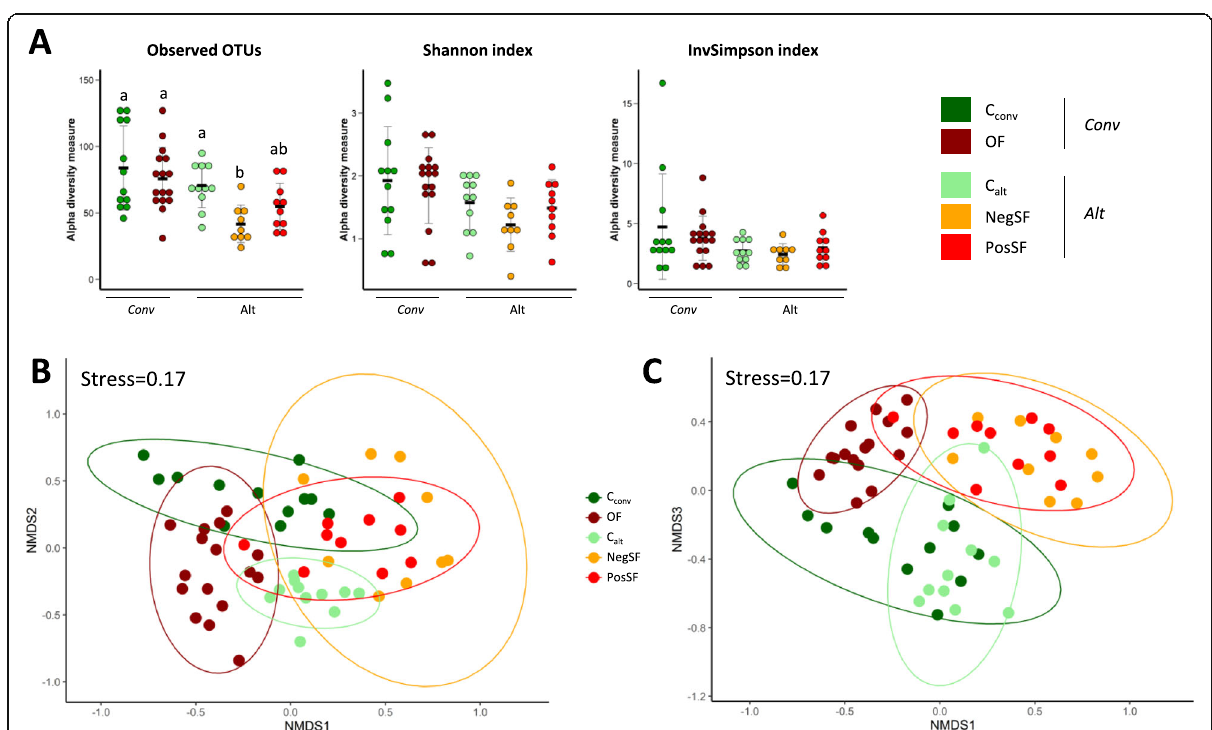
Fig. 3 Alpha and Beta diversity of the microbial community according to the experimental group. a Alpha diversity, means are presented by black horizontal lines and SD as grey error bars; b - c nMDS representation of the beta diversity (Bray Curtis, stress = 0.17) according to ( b ) axes 1 and 2 and ( c ) axes 1 and 3. Conv: Conventional breeding system, Alt: Alternative breeding system. C conv : Control group before overfeeding, OF: Overfed group, C alt : Control group before Ad libitum corn mixture feeding, NegSF: Negative response groupe to spontaneous fattening induction, PosSF: Positive response groupe to spontaneous fattening induction. Within a plot, groups with different superscripts differ ( P < 0.05) according to a Wilcoxon non parametric